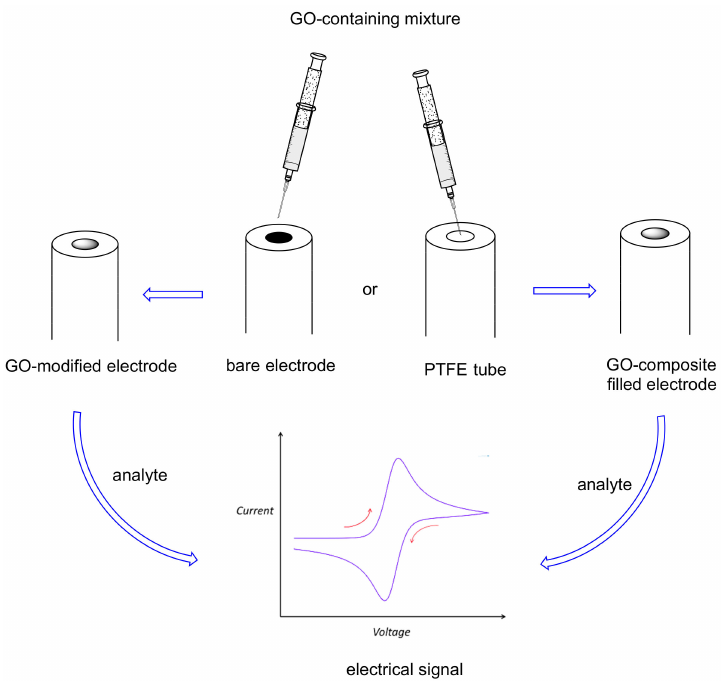
Figure 4. GO use for methylxanthines electrochemical